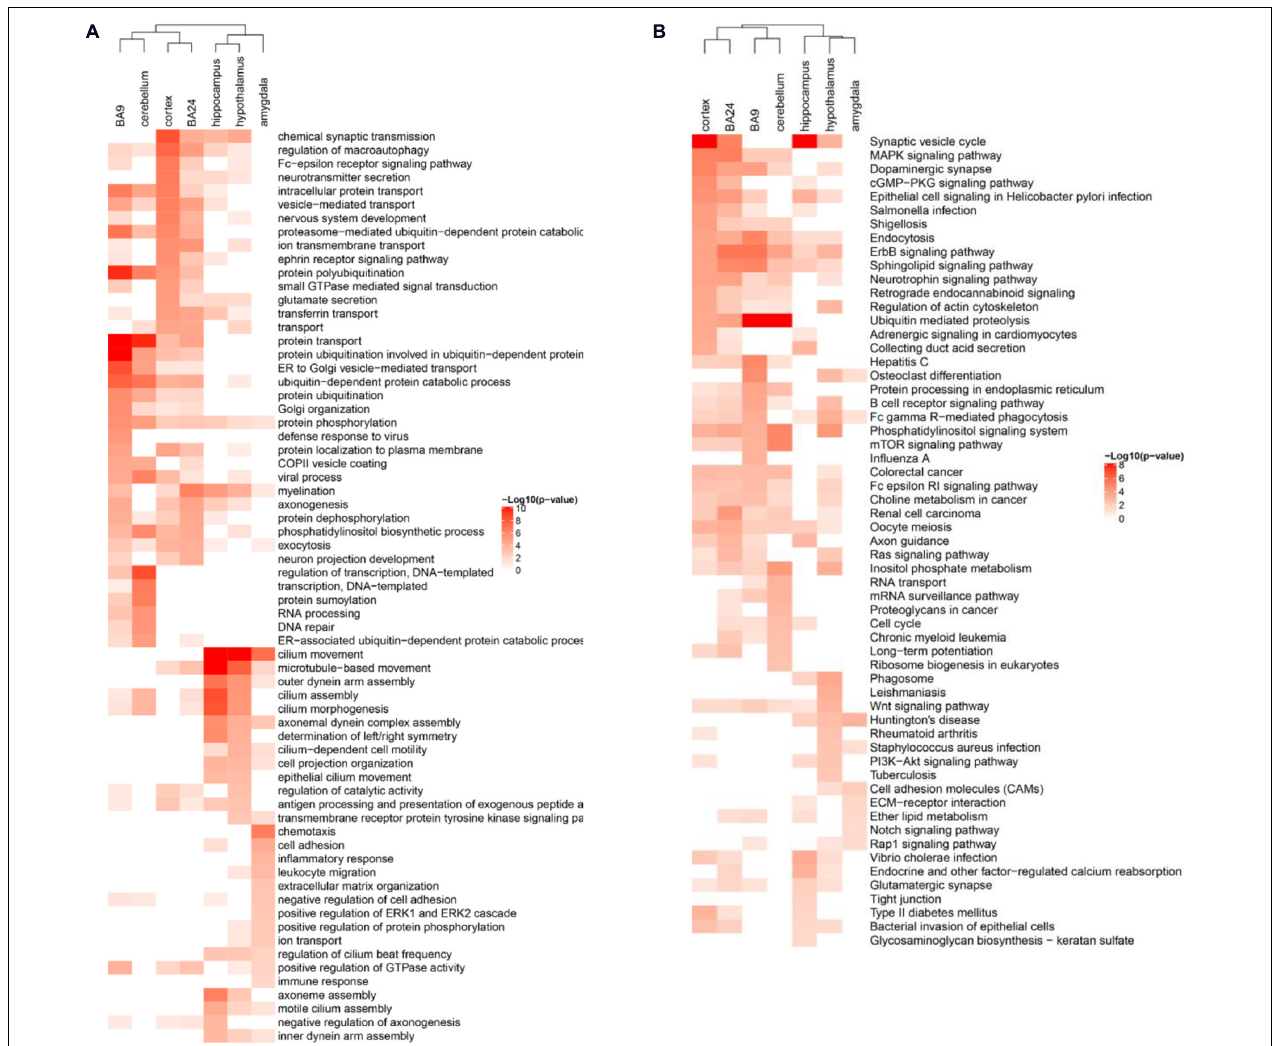
FIGURE 5 | Differentially enriched functional terms of ASD-related lncRNAs in distinct brain regions. Heatmaps display enriched (A) GO BP terms and (B) KEGG pathways of gene co-expression neighbors of ASD-related lncRNAs in different brain regions. Only the top 15 terms with p -value < 0.05 in each brain region were depicted for both functional